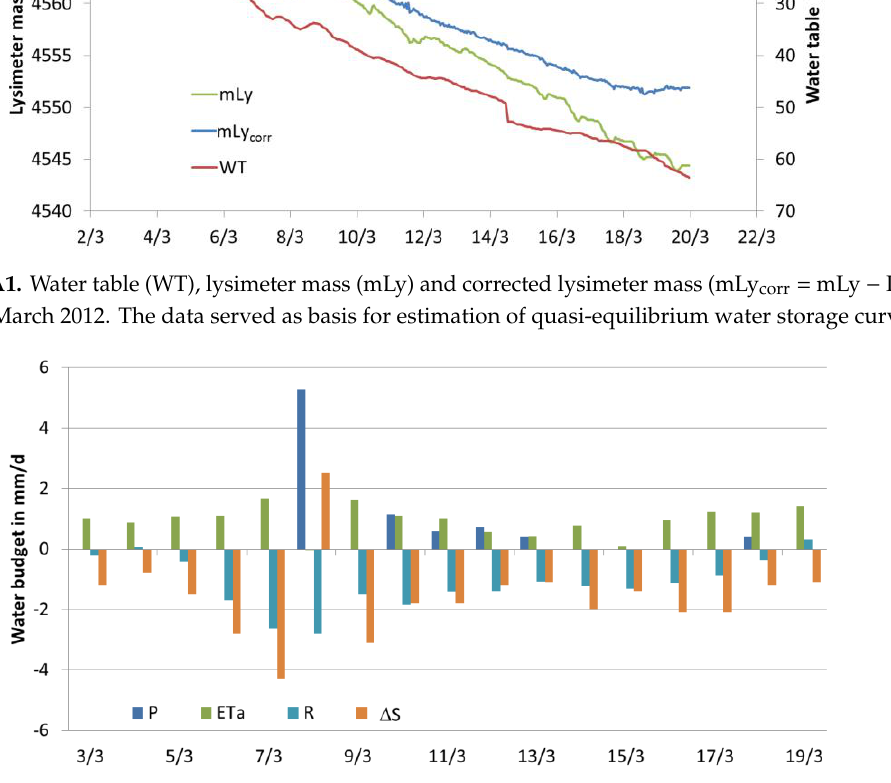
Figure A2. Daily water budget components during the period in March 2012 that was used to estimate the quasi-equilibrium water storage curve (P—precipitation, ETa—evapotranspiration, R—inflow/outflow, S—water storage change).